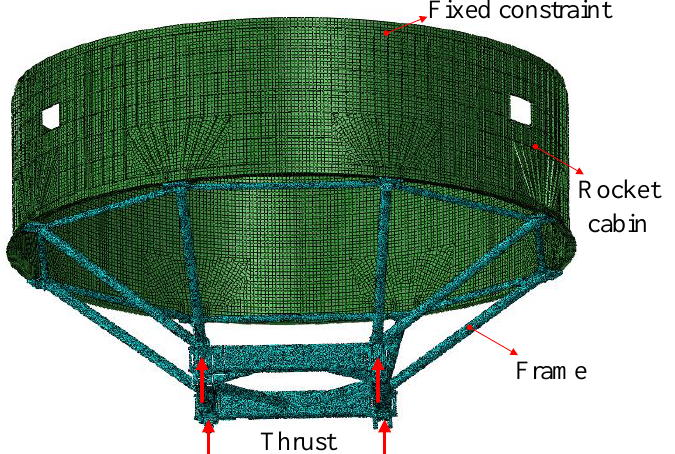
Figure 16. FEM of the rocket engine frame.